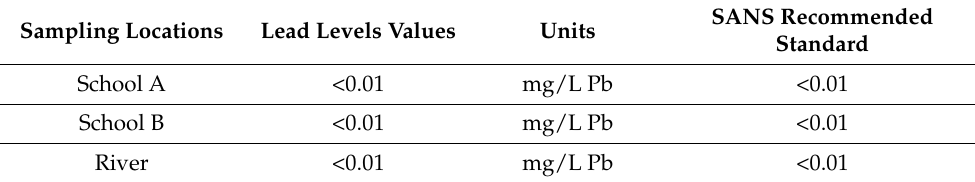
Table 2. Levels of lead in drinking water from different locations. Sampling